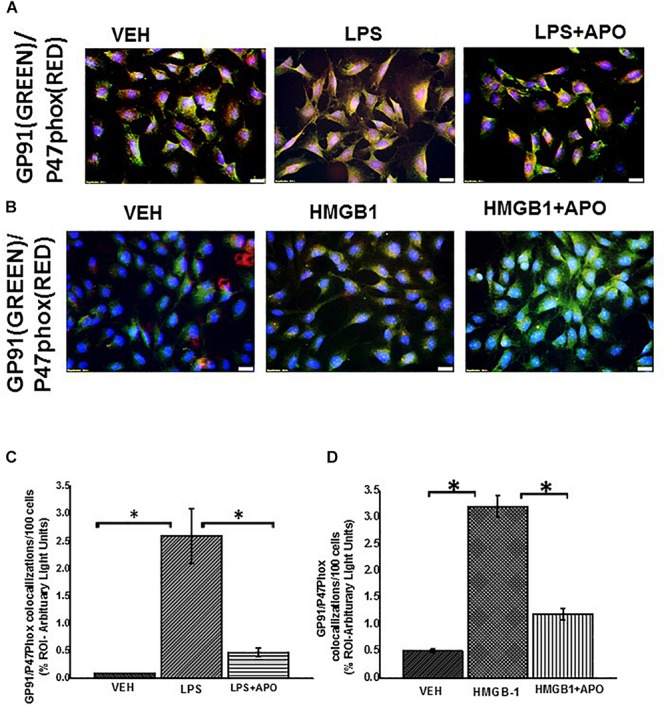
NADPH oxidase 2 activation in rat EGC. (A,B) Activation of NOX-2 in rat EGC (n = 6). Activation of NOX 2 was studied through observing colocalizations between GP91phox (labeled with green fluorescent antibody) and P47 phox (labeled with red fluorescent antibody) subunits of the NADPH 2 oxidase complex resulting in a yellow region. Colocalization (yellow) of GP91phox and P47phox was detected in vehicle VEH, LPS, LPS + apocynin (LPS + APO), HMGB-1, HMGB-1 + APO treated cells at total magnification 400X; scale 20 μm). (C,D) Morphometric analysis of GP91/p47phox colocalization events in rat EGC per 100 cells in different fields (∗P < 0.05).